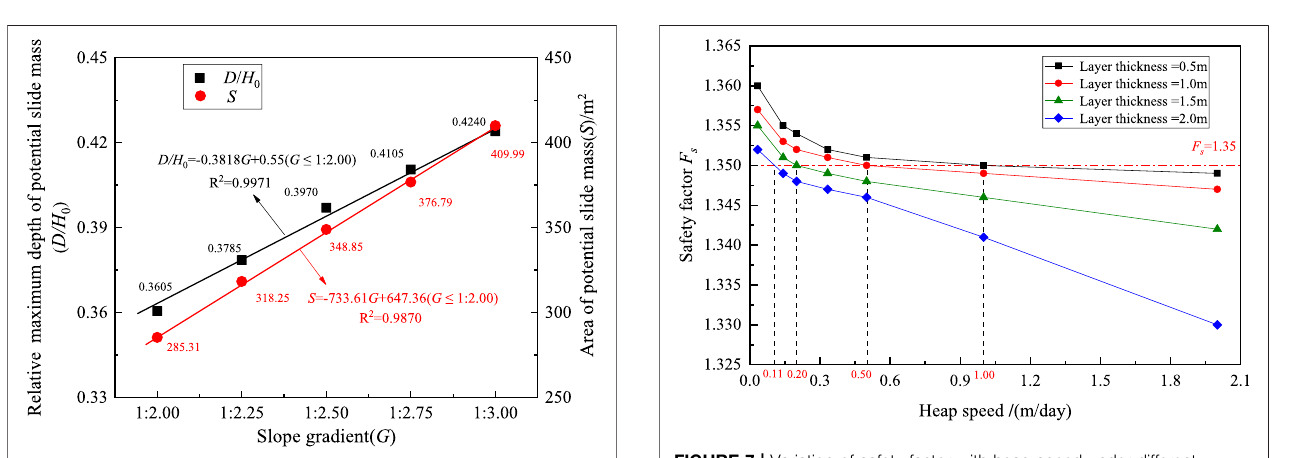
FIGURE 7 | Variation of safety factor with heap speed under different layer